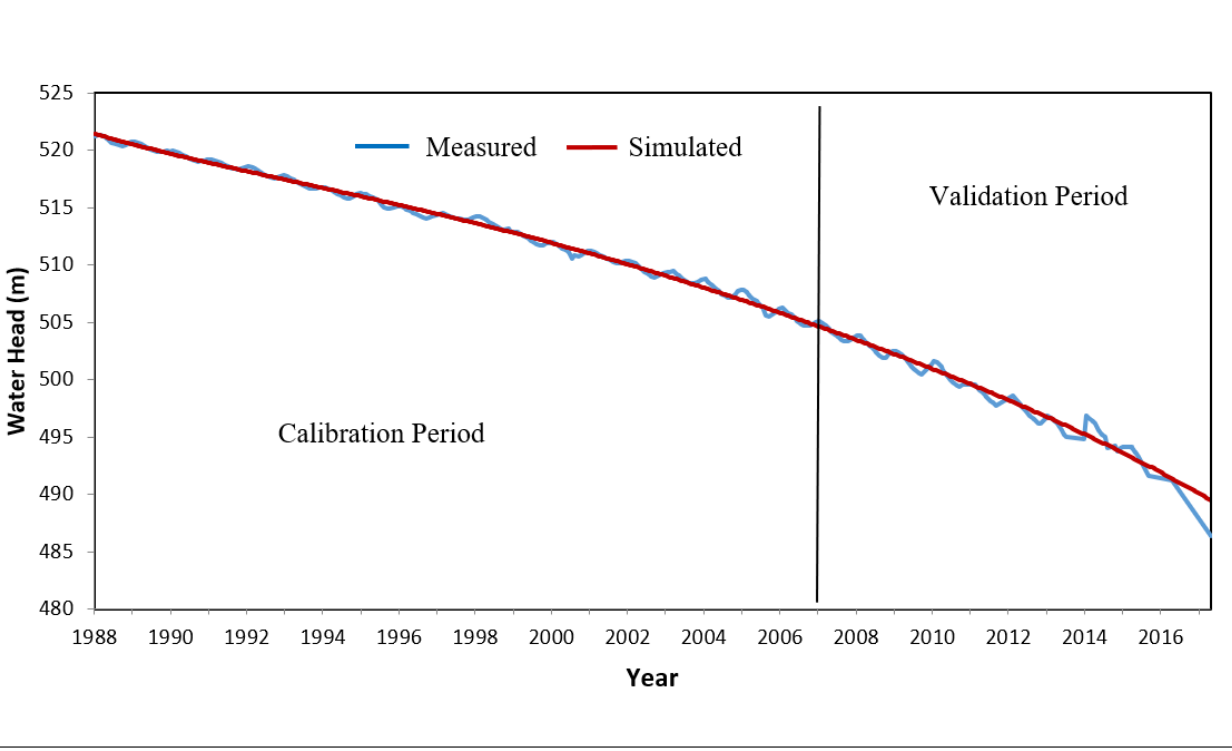
Figure 11 . The comparison of observed and simulated fluctuations in the G.W. heads in the observation well (AL 2698).